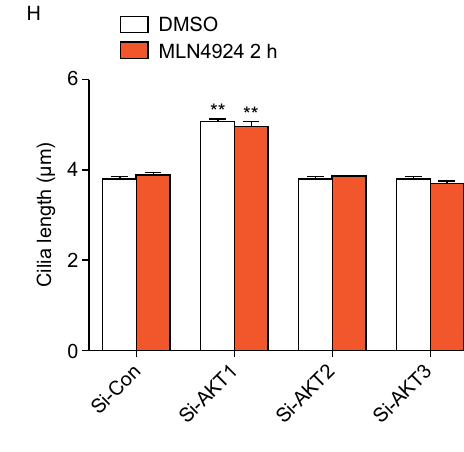
b Figure 4. AKT1, but not its family members, AKT2 or AKT3, regulates ciliogenesis and disassembly. (A – D) Effect of AKT family members: BEAS2B cells were transfected with scram- bled control siRNA, siAKT1, siAKT2 or siAKT3, then treated with DMSO or MLN4924 (0.3 μ mol/L) under cilia initiation condition for indicated periods of time, followed by western blotting with indicated Abs (A) or immuno fl uoresence staining of cilia and photography (B). Percentage of ciliated cells were counted (C) or cilia length measured (D), the results plotted. Shown is mean ± SEM from three independent experiments. ** P < 0.01, *** P < 0.001. (E – H) Effect of knockdown of AKT family members on cilia disassembly and growth: BEAS2B cells were transfected with scrambled control siRNA, siAKT1, siAKT2 or siAKT3, then treated with DMSO or MLN4924 (0.3 μ mol/L) under cilia disassembly condition for 2 h, followed by Western blotting with indicated Abs (E) or immuno fl uores- ence staining of cilia and photography (F). Percentage of ciliated cells were counted (G) or cilia length measured (H), the results plotted. Shown is mean ± SEM from three independent experiments. ** P <